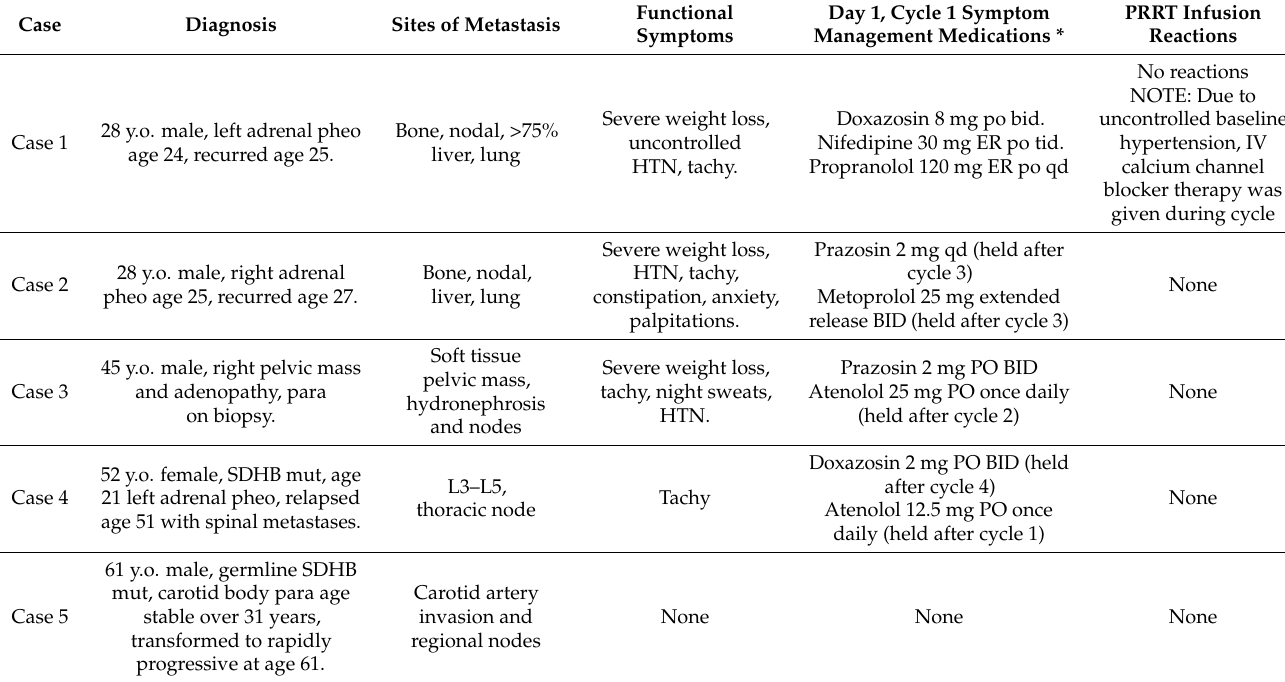
Table 1. Characteristics of five patients diagnosed with pheochromocytoma/paraganglioma treated with